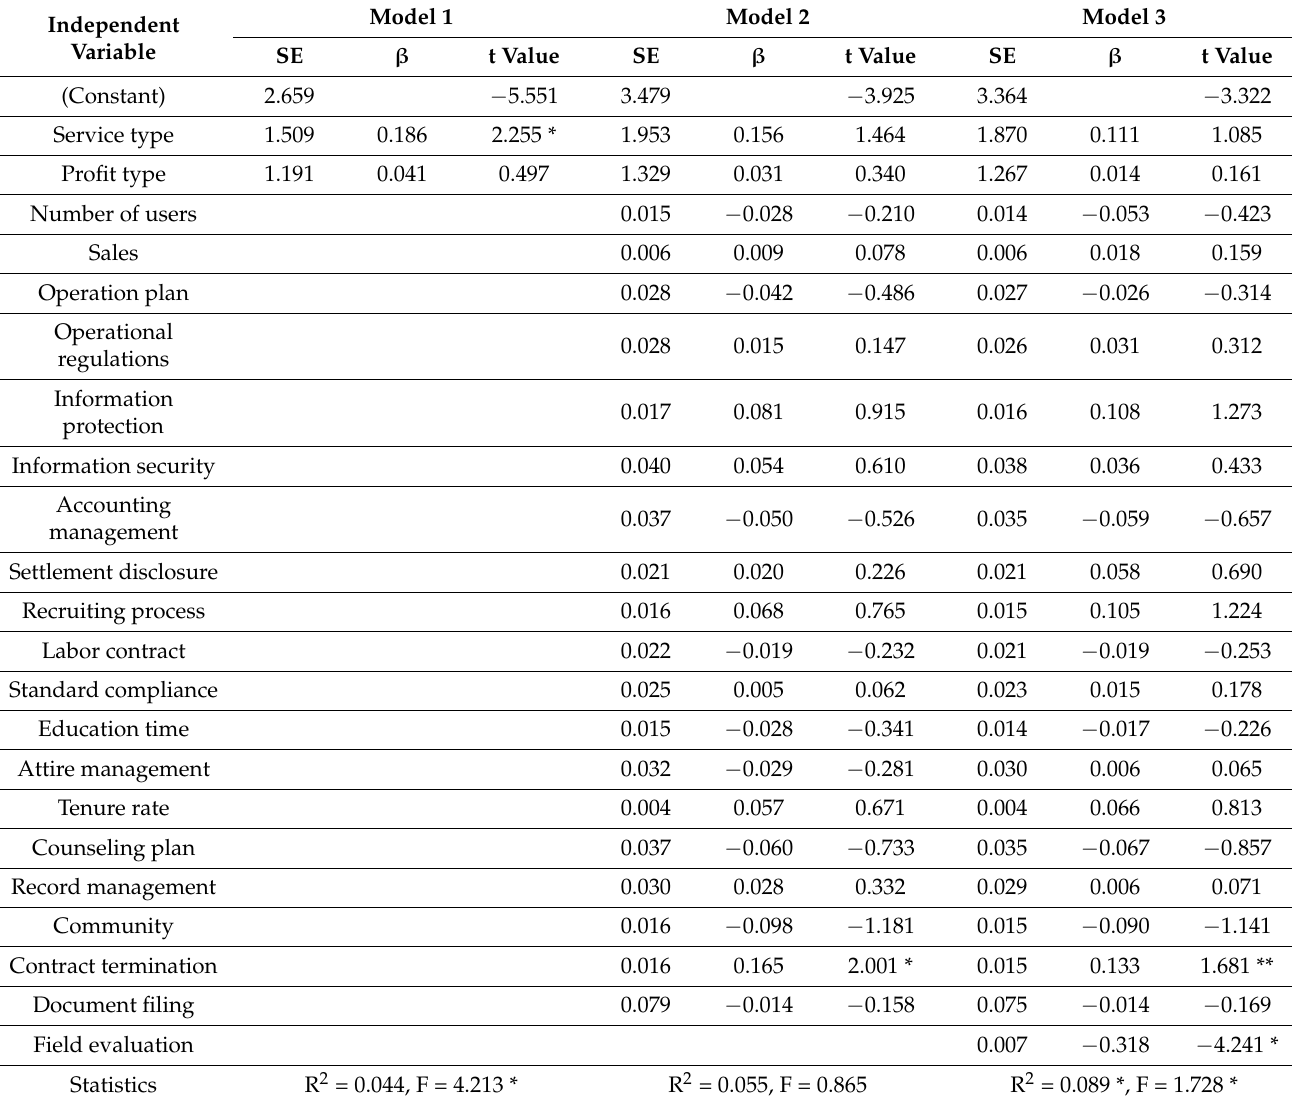
Table 6. Hierarchical regression analysis (DID). ( n =